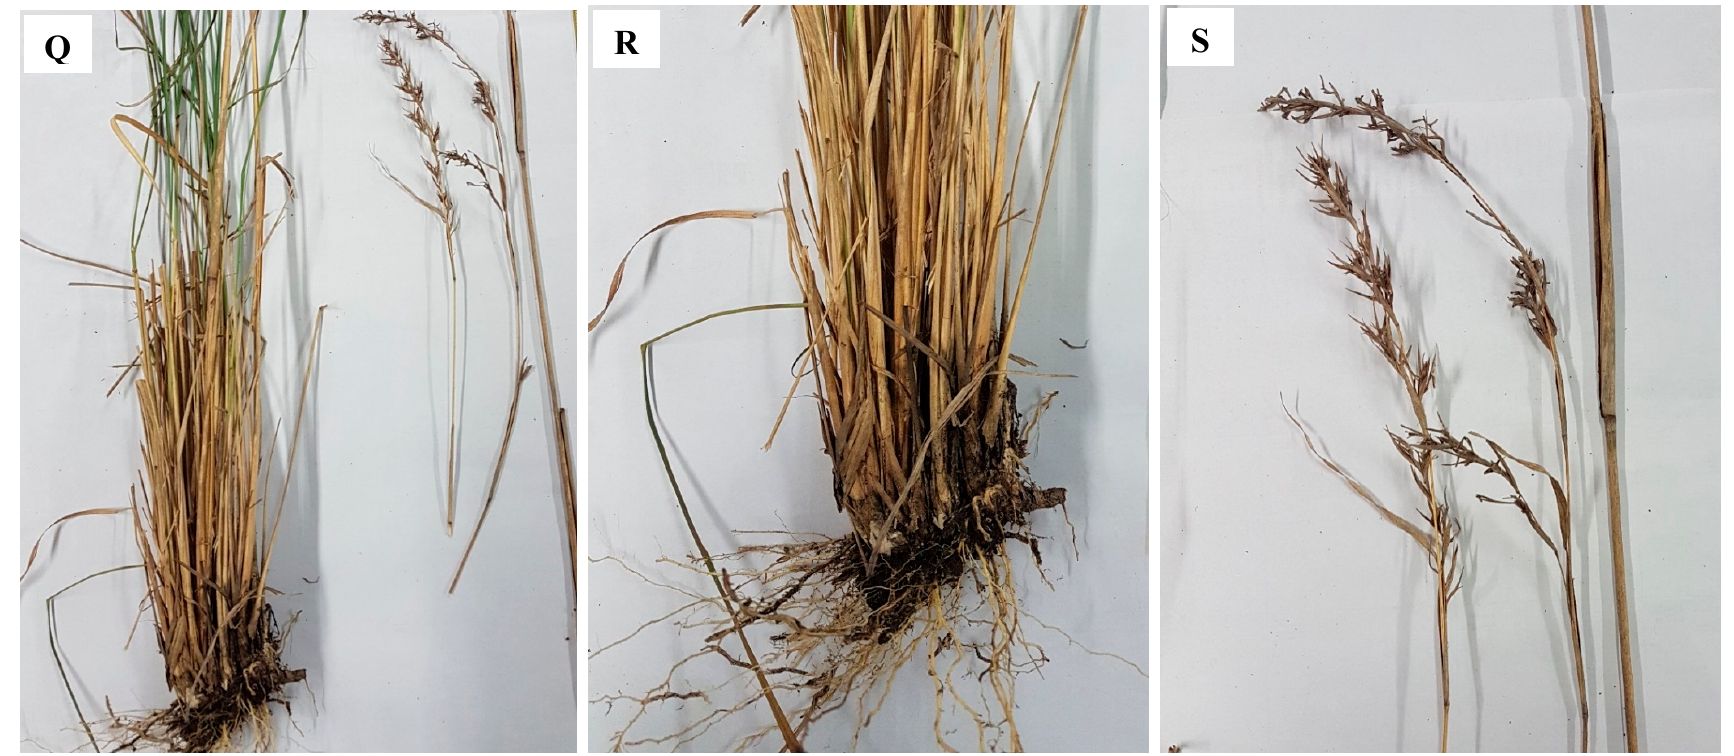
Figure A1. Some of the grasses that are used in South African traditional medicine include, Eragrostis plana ( A, B ); Cynodon dactylon ( C, D ); Eragrostis curvula ( E, F, G, H ); Vetiveria zizanioides ( I, J ), Setaria megaphylla ( K, L, M ); Sporobolus africanus ( N, O, P ) and Cymbopogon validus ( Q,R,S ).